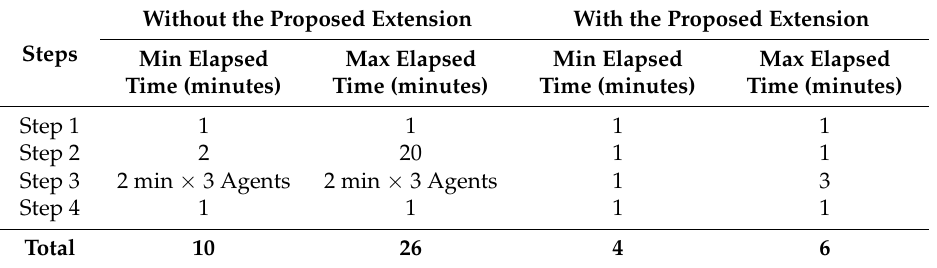
Table 3. Elapsed Times for Scenario 2—without and with the proposed